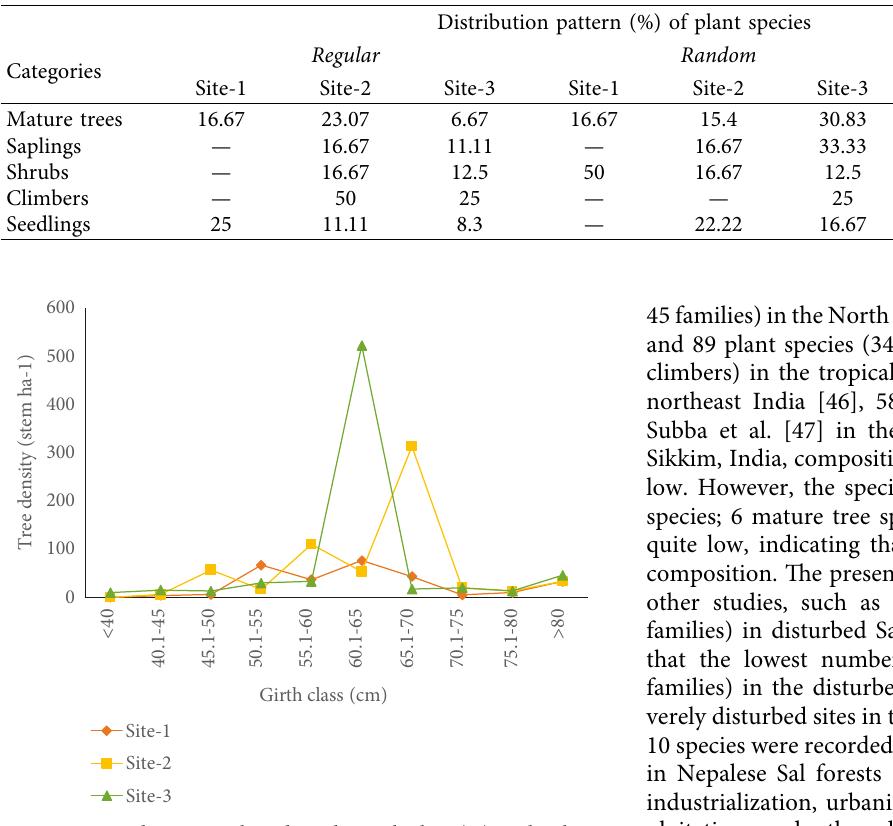
Figure 6: Stand structure based on the girth class ( m ) in the three sites of study